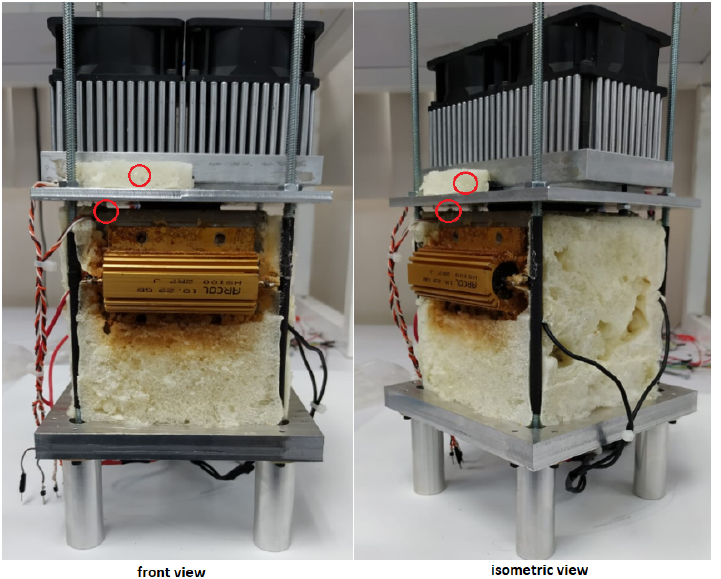
Figure 3. Assembled prototype, the polyurethane insulation was removed to expose some of the components. The red circles indicate the position of the temperature sensors.